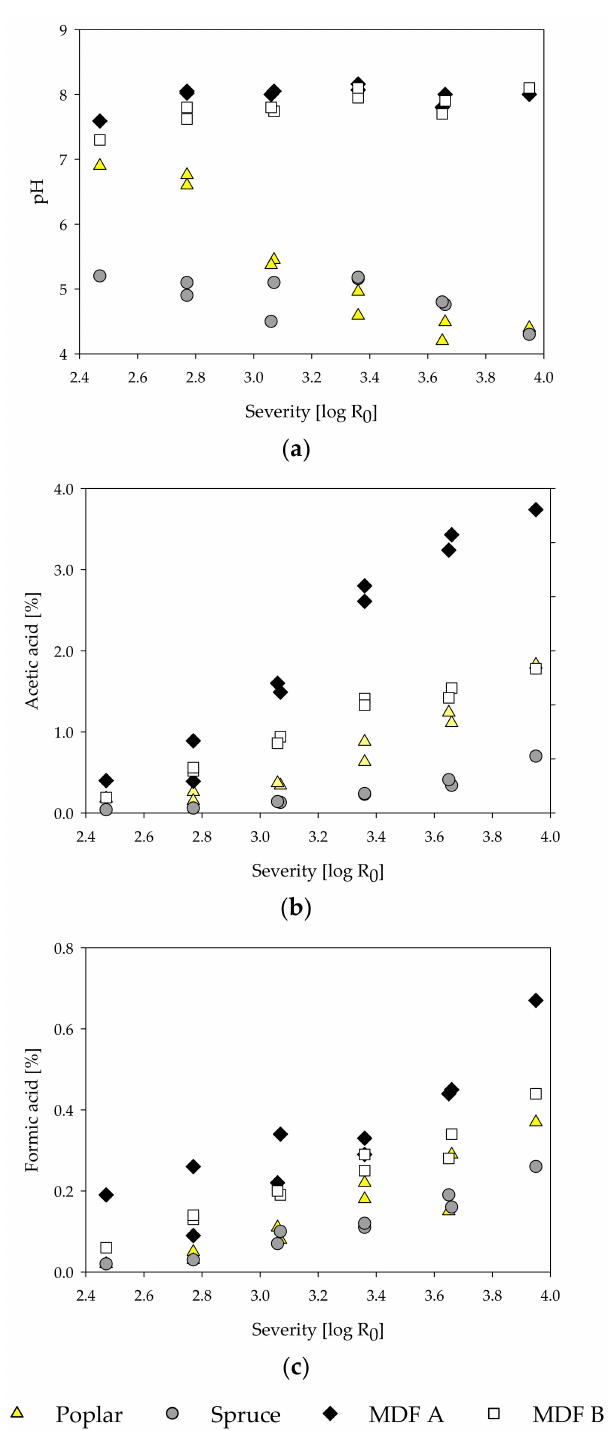
Figure 4. Influence of treatment severity on pH ( a ), and acetic acid ( b ) and formic acid ( c ) contents of steam-refining extracts of poplar, spruce, and the MDF